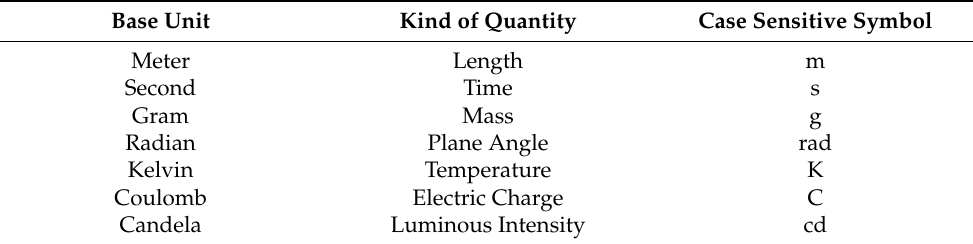
Table 1. This table contains all seven base units used within UCUM